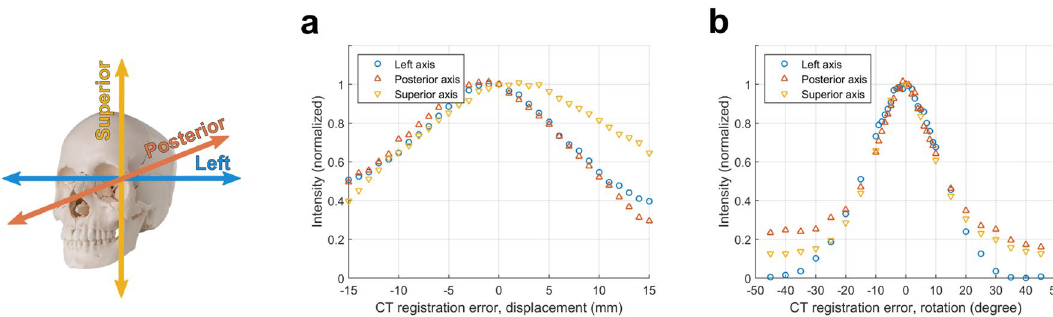
Figure 6. Effects of CT misregistration on normalized target intensity. ( a ) Displacement and ( b ) rotation errors were applied along one dimension only. Axes are colored according to their corresponding